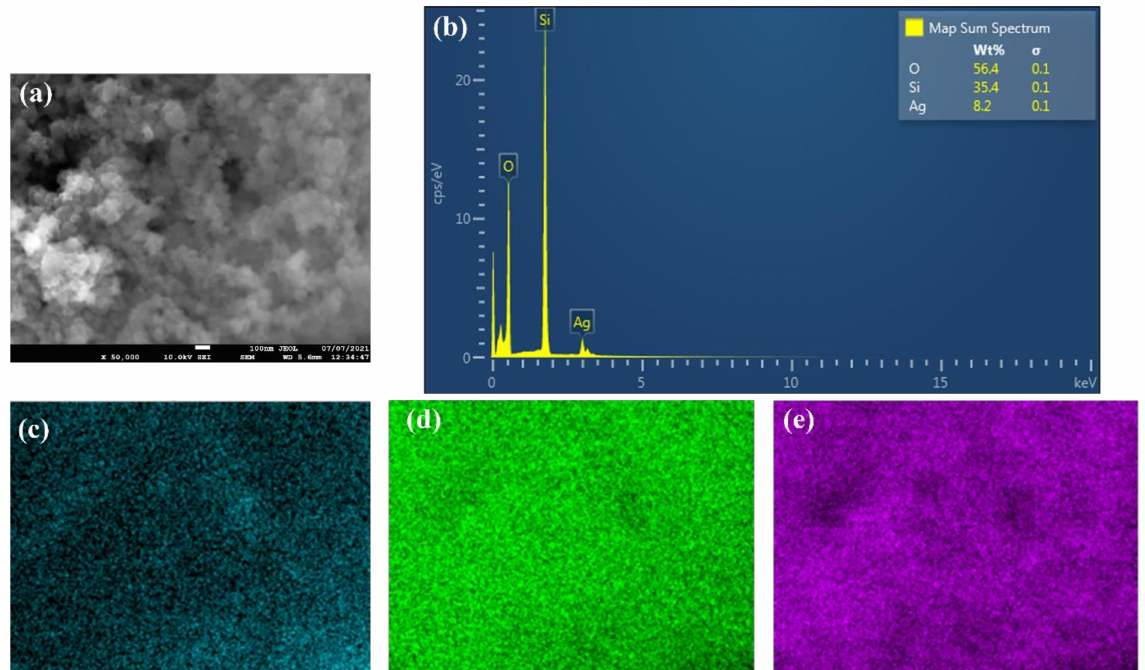
Figure 3. EDS analysis of the as-received powder, where ( a ) shows the SEM image in which the analysis was conducted, ( b ) demonstrates the elements’ wt %, and ( c – e ) illustrate the distribution of Ag, Si, and O elements,